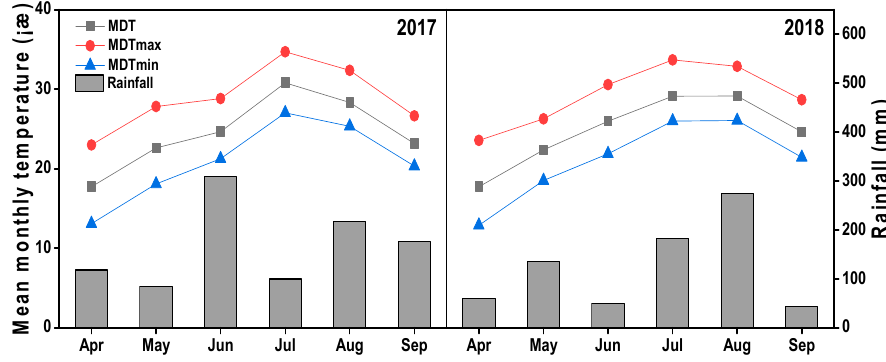
Figure 1. Mean monthly air temperature and rainfall during 2017 and 2018.